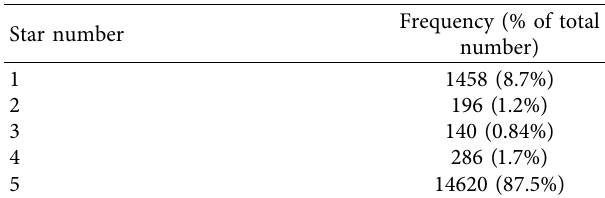
Table 10: Spread of star rating scores in all analyzed patient-written